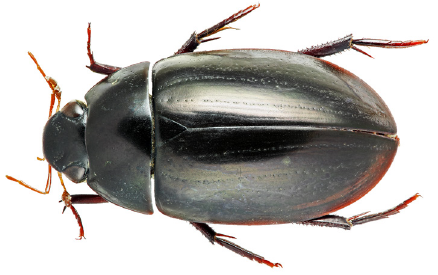
Figure 24. Hydrochara fulvofemorata (Fairmaire, 1869) 16.2 mm, iSimangaliso Wetland Park, False Bay (site 27), January 2015 DT Bilton, MS Bird & R Perissinotto